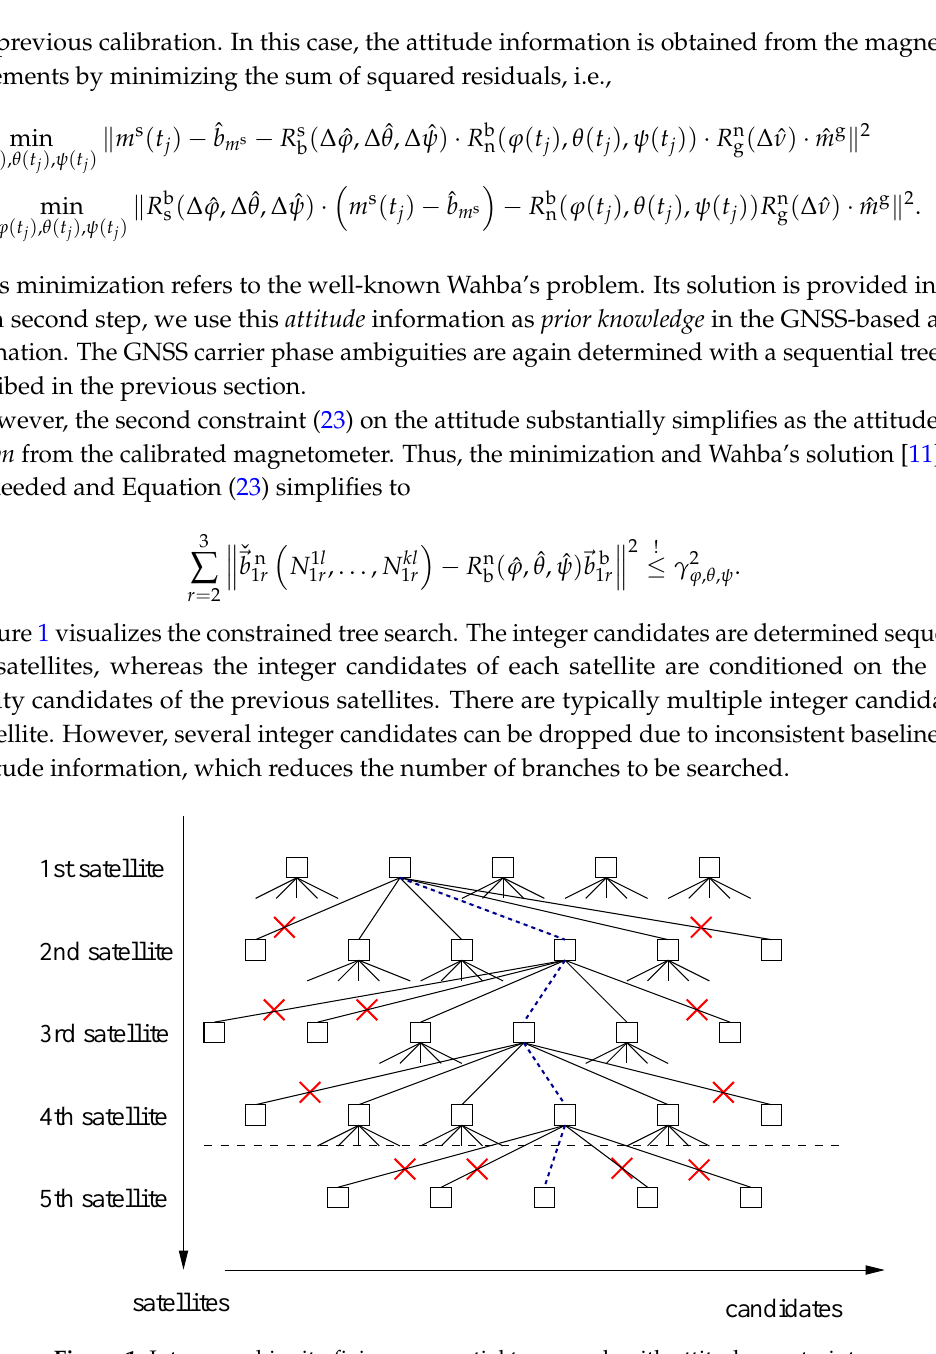
Figure 1. Integer ambiguity fixing: sequential tree search with attitude